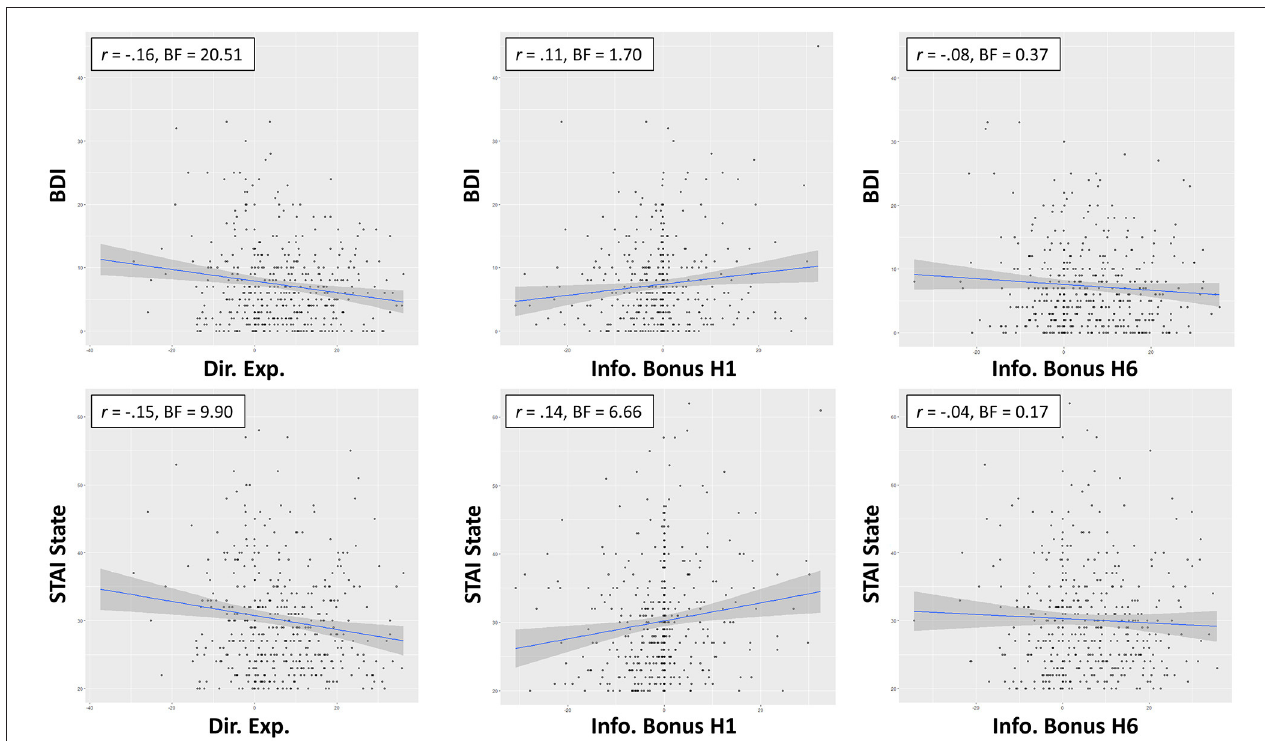
FIGURE 2 | Zero-order relationships between directed exploration and depression (BDI) and state anxiety (STAI). Relationships between information bonus in H1 and H6 trials suggested this was explained in part by greater information seeking in H1 trials with more severe symptoms.